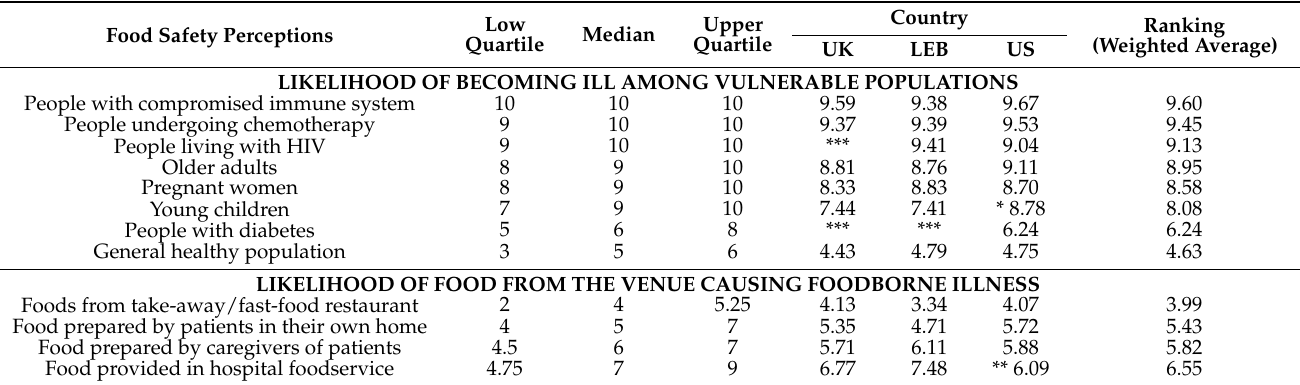
Table 4. Perception of food safety risks to vulnerable populations and perception of food safety risks from different food preparation venues among students enrolled in dietetics programs in United Kingdom ( n = 78), Lebanon ( n = 29) and United States ( n =